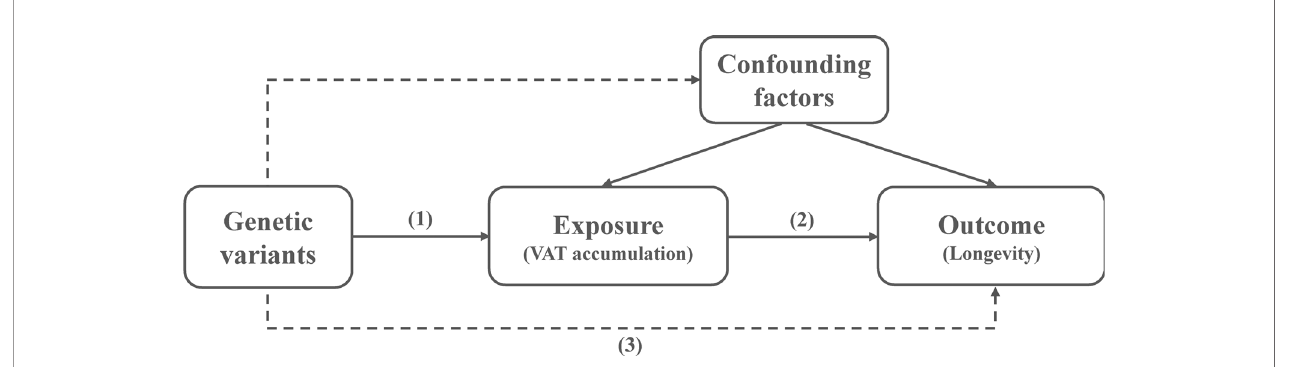
FIGURE 1 | The schematic diagram for the Mendelian randomization